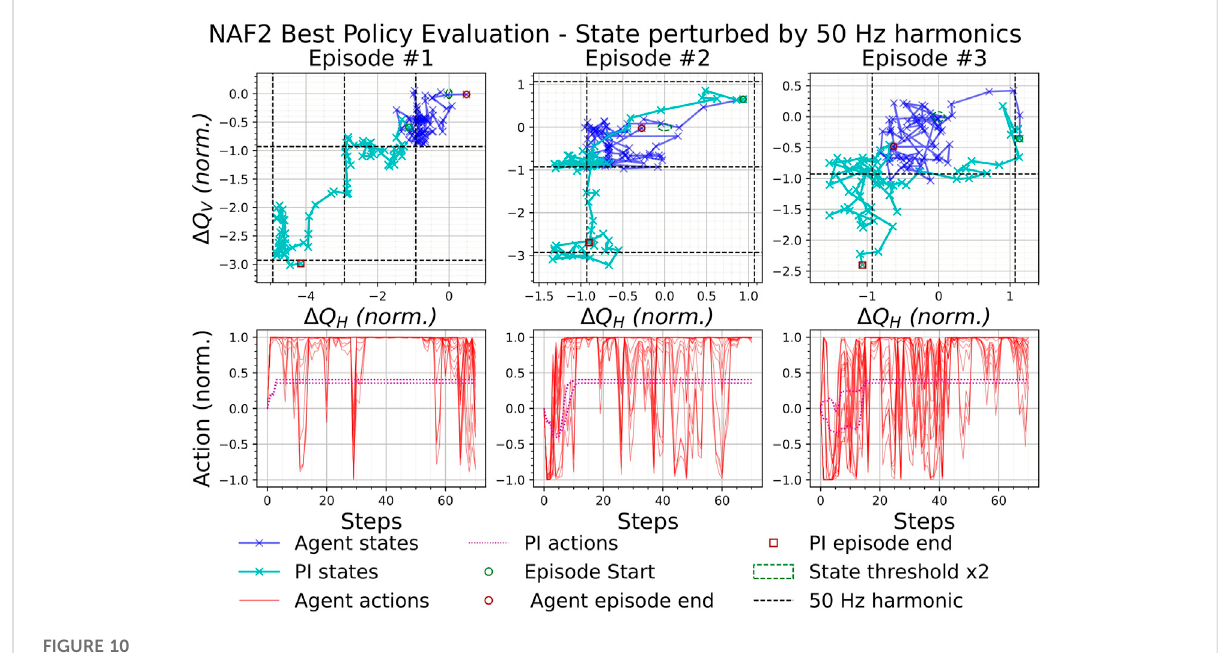
FIGURE 10 Effect of inaccurate tune estimation on the best NAF2 agent.